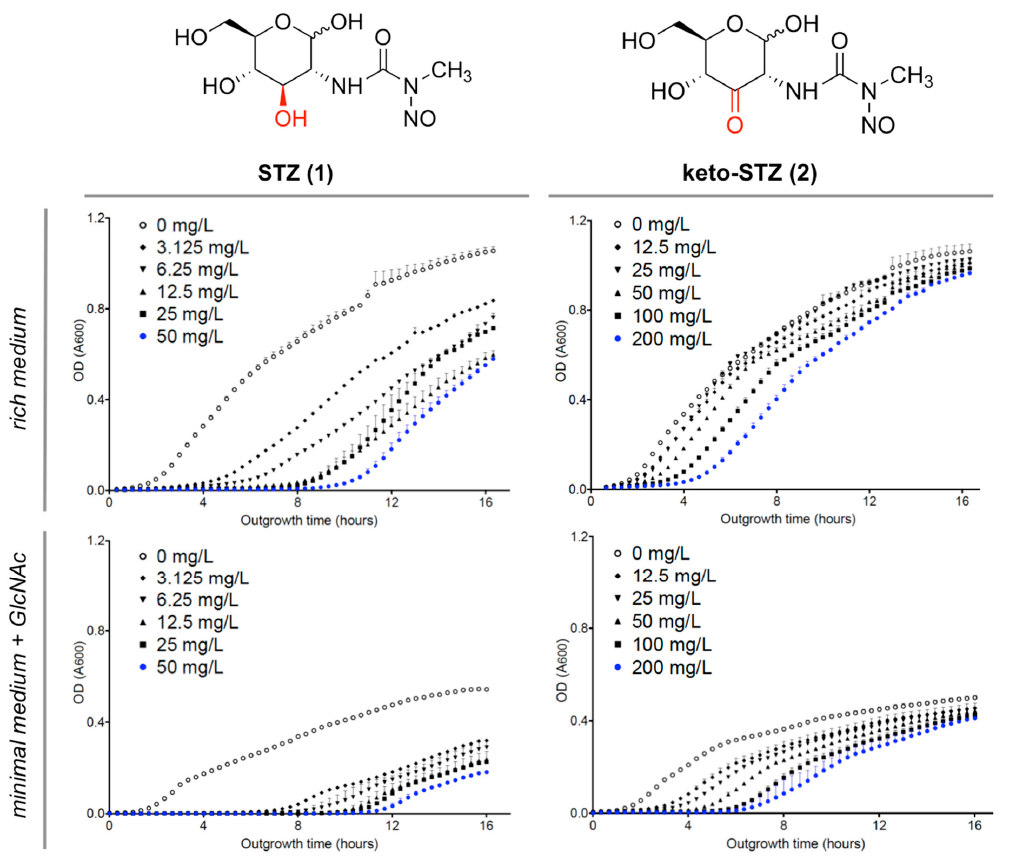
Figure 3. Growth-based viability curves of E. coli for STZ 1 ( top left ) and keto-STZ 2 ( top right ) in rich medium, and for STZ 1 ( bottom left ) and keto-STZ 2 ( bottom right ) in minimal medium + GlcNAc. Experiments are performed in triplicate.